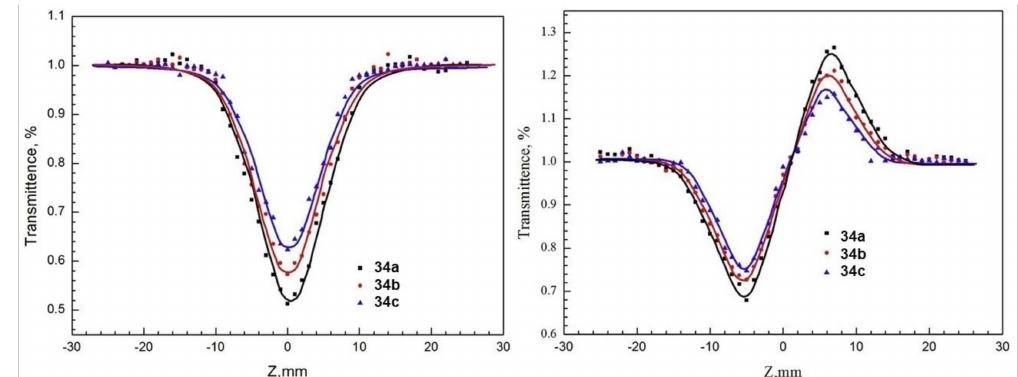
Figure 14. The nonlinear absorption and fitting curves (solid lines) of polymeric carboxyl phthalocyanines Z-scan (left: closed aperture; right: open aperture). Adapted with permission from ref [144]. Copyright 2017 American Chemical Society.